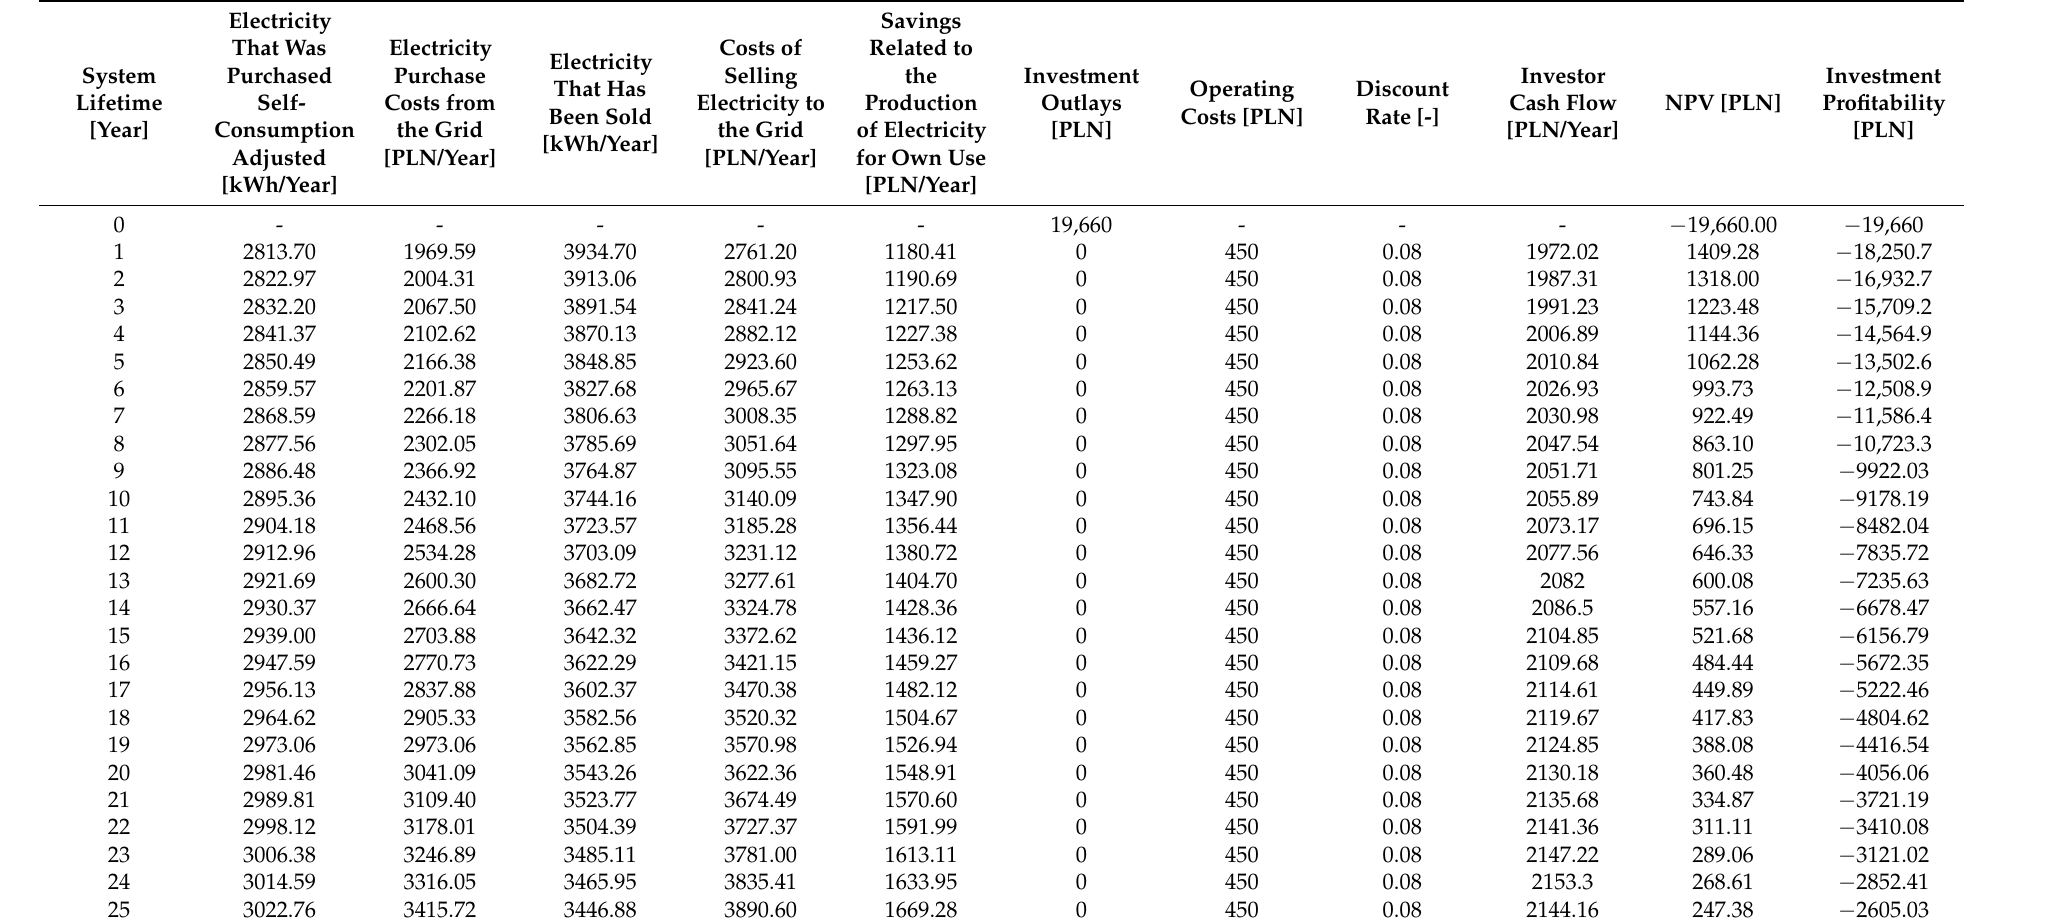
Table A2. NPV results of the PV installation for the net-billing system based on monthly prices, at a 30% self-consumption